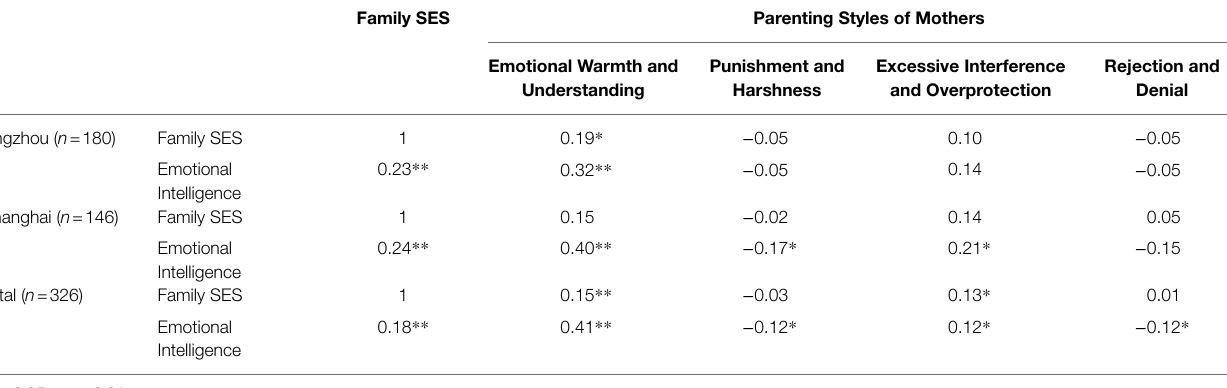
TABLE 5 | The correlation between primary school students’ family socioeconomic status, mother’s parenting style, and emotional intelligence.